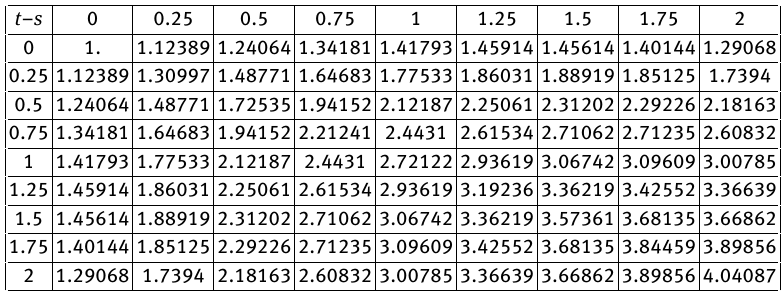
Table 6: Approximation of C ov[ X ( t ), X ( s )] via adapted gPC with p = 3 and p = 4 . Example 4.1, assuming dependent random data.